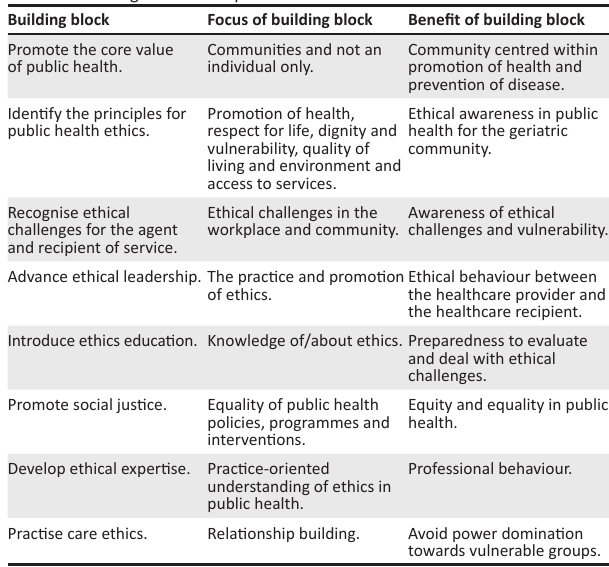
TABLE 4: Building blocks for a public health ethics